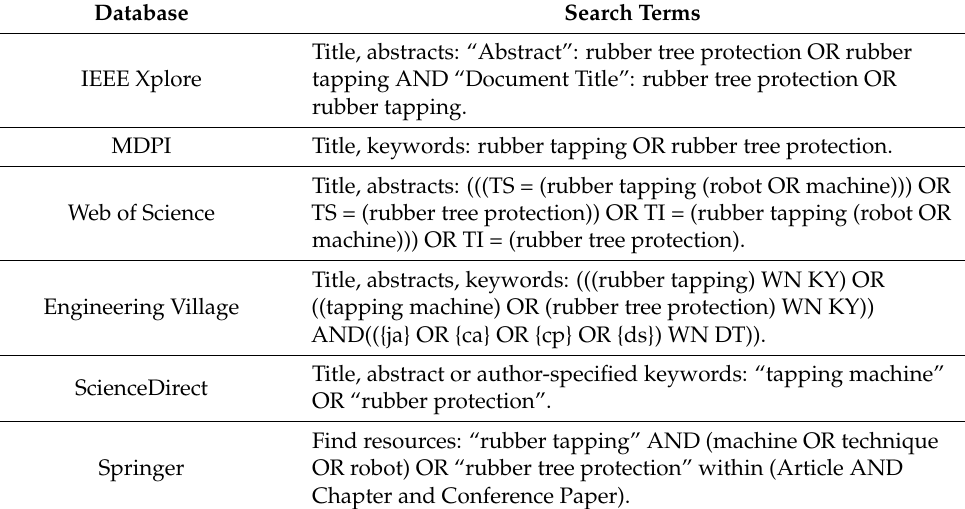
Figure 2. Literature selection methodology, including searching scope, selection criteria, and the number of articles included and excluded. Table 1. The search strategies.